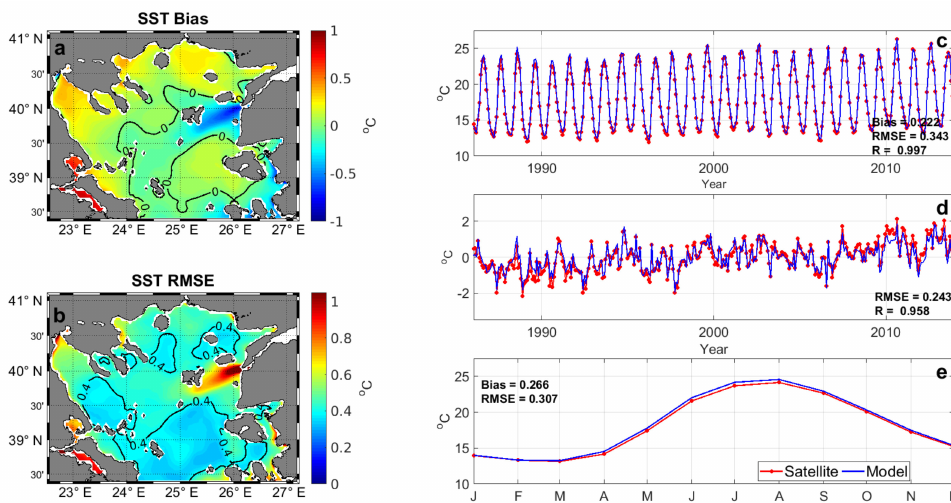
Figure 2. Sea–Surface Temperature-based validation of the model: Maps of the Bias and RMS error of the model, estimated at each point of the computational grid for the period 1986–2013 are presented in panels ( a , b ), respectively. Time series of the geographical mean SST of the model (blue) and the satellite observations (red) are presented in ( c ). The temporal SST anomaly computed over the domain is presented in ( d ), and the modelled and observed seasonal SST cycle in ( e